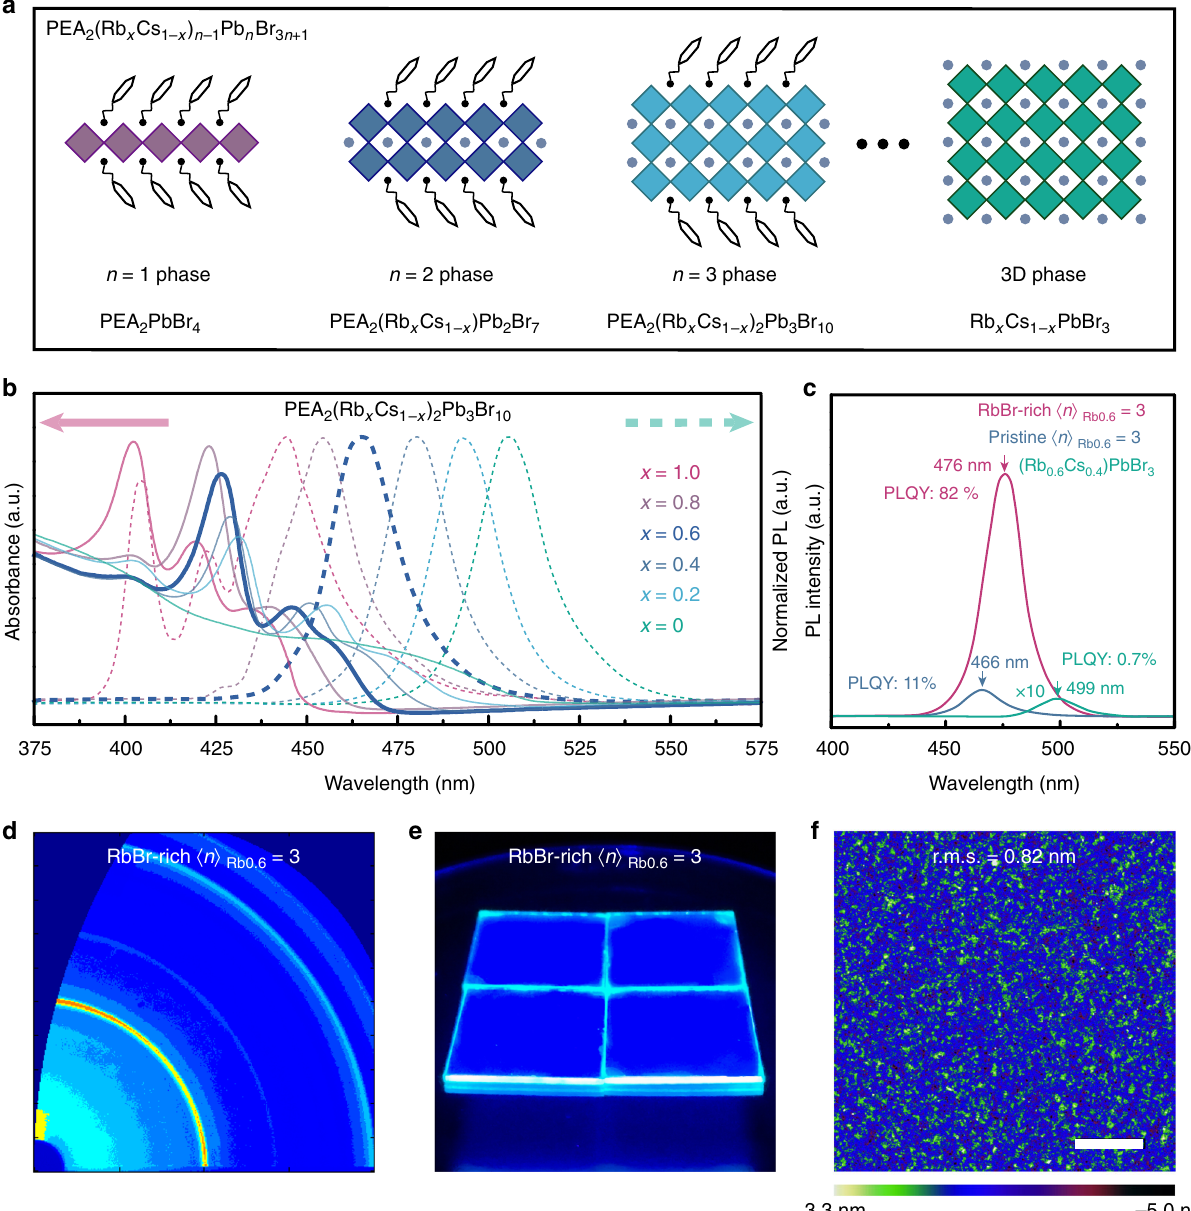
Fig. 1 Characteristics of perovskite fi lms. a Cartoon structure of Cs – Rb alloyed quasi-2D PEA 2 (Rb x Cs 1 − x ) n − 1 Pb n Br 3 n + 1 perovskites. b UV – vis absorption and steady-state PL spectra of pristine 〈 n 〉 = 3 PEA 2 (Rb x Cs 1 − x ) 2 Pb 3 Br 10 (0 ≤ x ≤ 1) perovskites. c Steady-state PL spectra and PLQYs of 3D perovskite Rb 0.6 Cs 0.4 PbBr 3 , pristine, and RbBr-rich 〈 n 〉 Rb0.6 = 3 fi lms. d GIWAXS pattern of the RbBr-rich 〈 n 〉 Rb0.6 = 3 fi lm. e Photoluminescence image of RbBr-rich 〈 n 〉 = 3 fi lms under excitation. f AFM height image of RbBr-rich 〈 n 〉 = 3 fi lm with a scale bar of 2 μ Rb0.6 Rb0.6